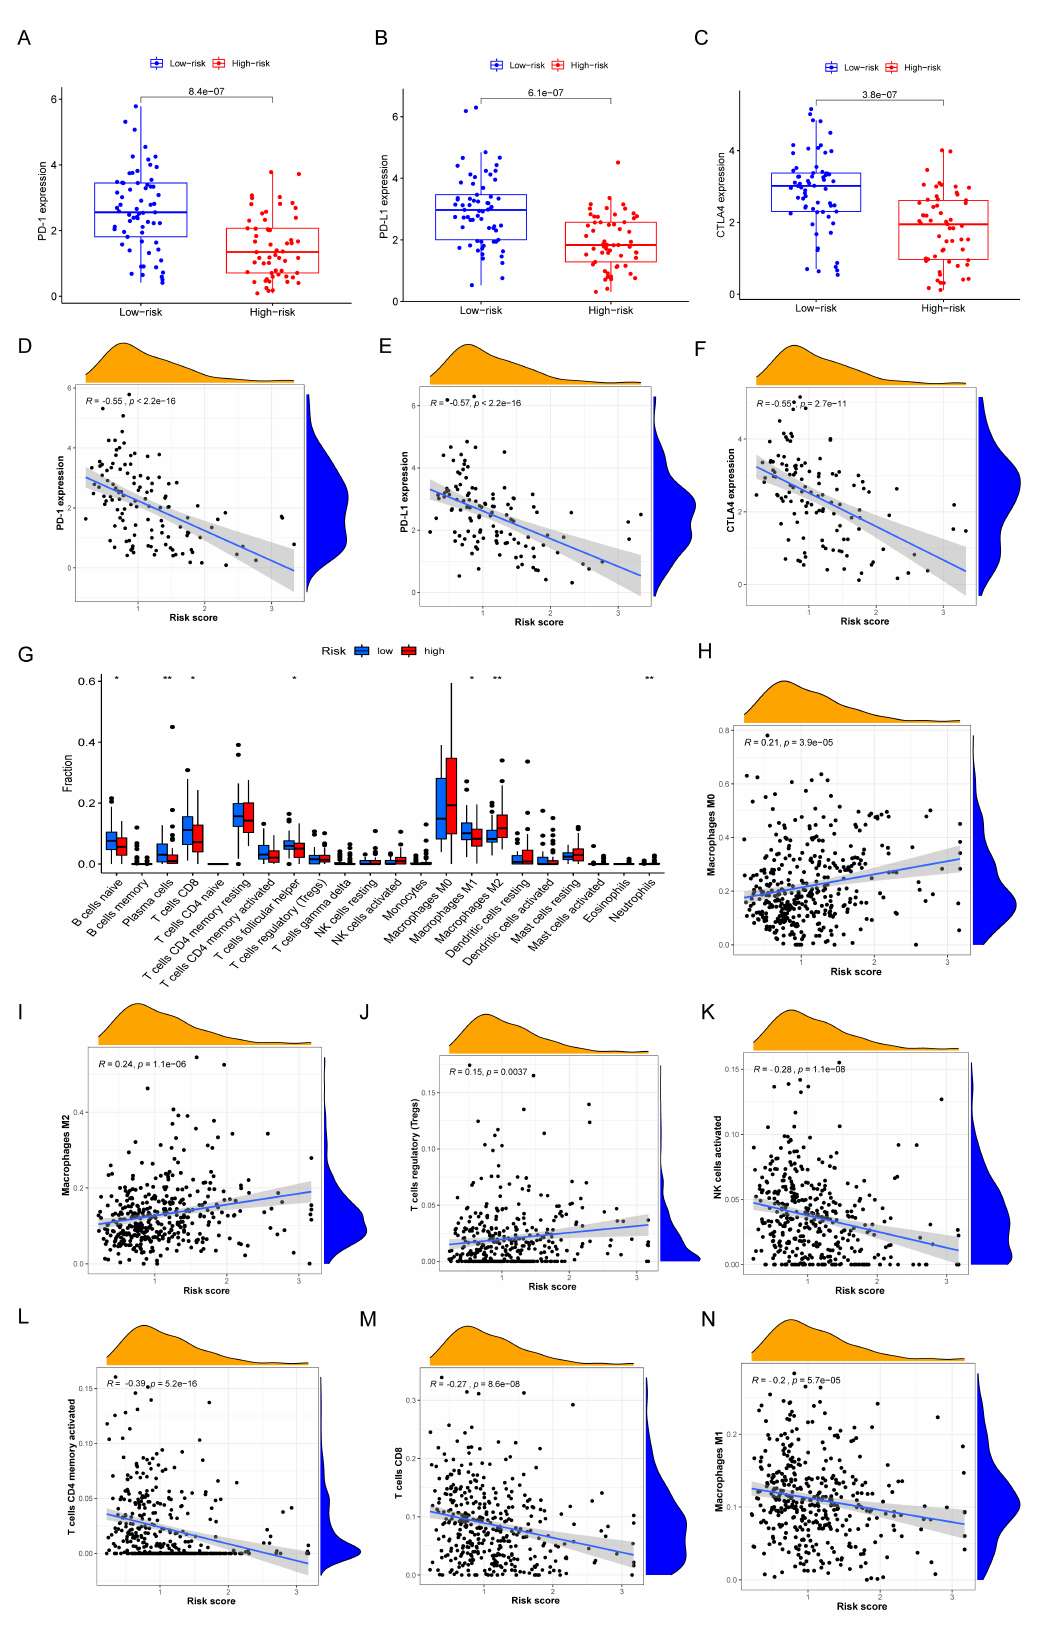
Figure 8. The immune characteristics of different IRGP subgroups. ( A – C ) The expression of PD–1, PD-L1, and CTLA–4 in high– and low–riskscore TNBC groups. ( D – F ) IRGP signature negatively